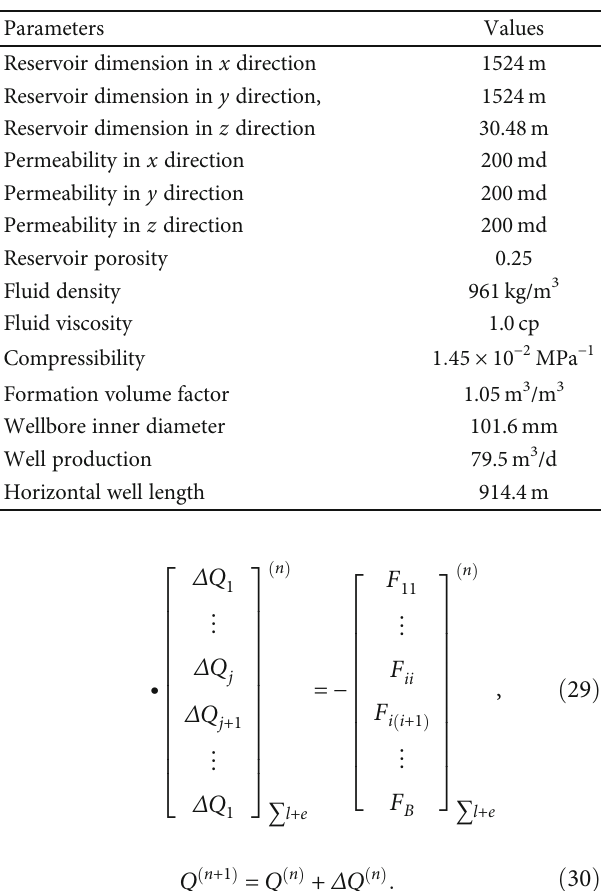
Table 1: Basic reservoir and fl uid